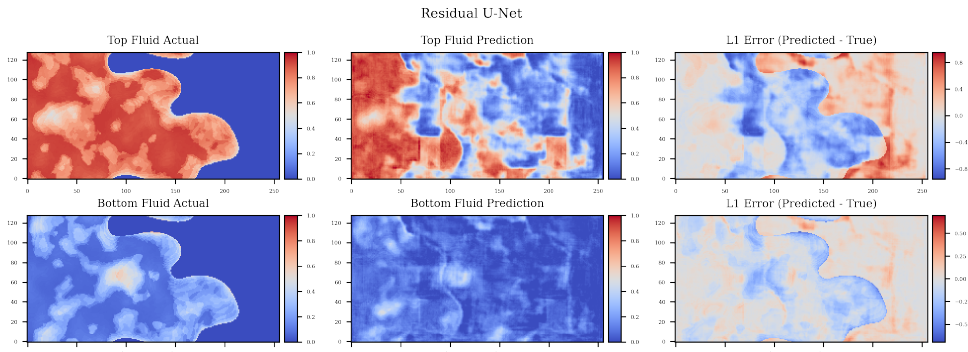
Figure 9. Residual U-Net with mean squared error (MSE) loss. With only the input and the target image, the network does not learn any useful relationship between the shape of the fracture and the distribution of CO 2